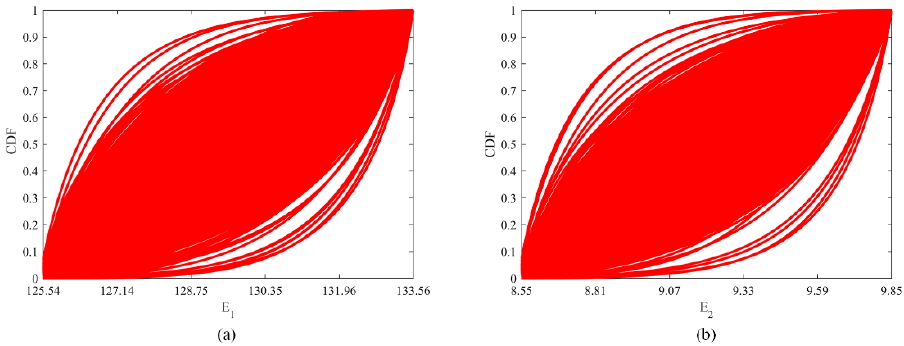
E , ( b ) E . Figure 2. Cumulative probability density functions of interval variables ( a ) E 1 , ( b ) E 2 1 2